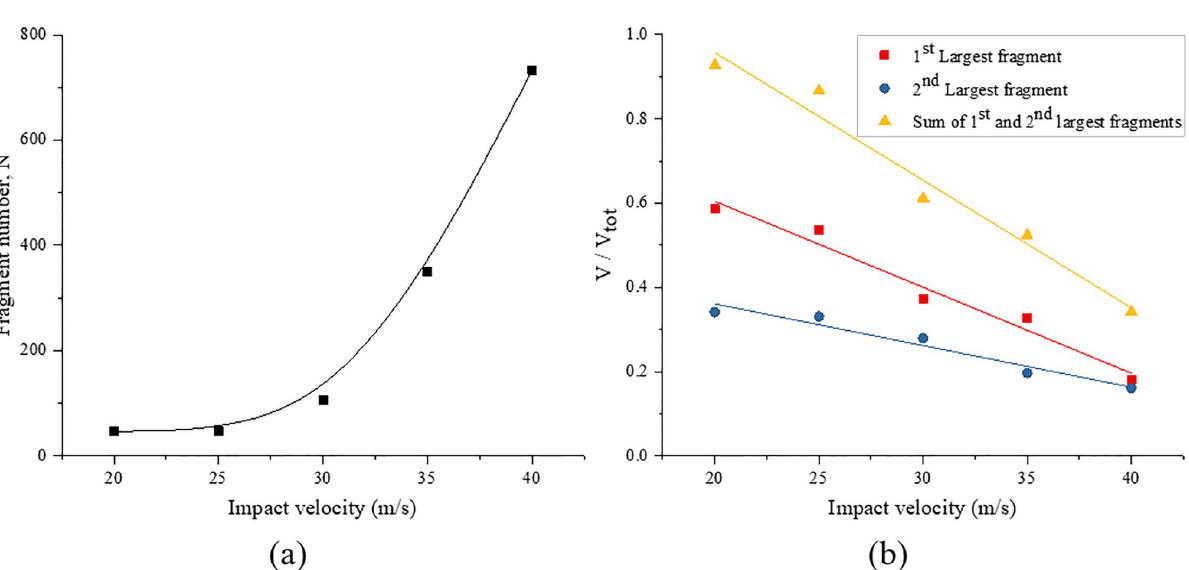
Fig 17. Fragmentation characteristics of the sample under different impact velocities. (a) fragment number; (b) the sizes of the two largest fragments and their sum.